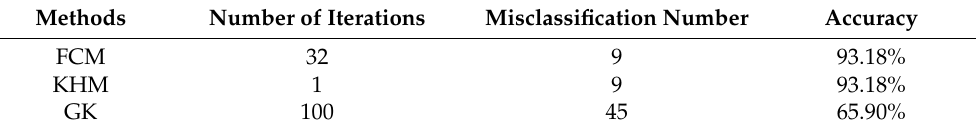
Table 2. The clustering results of FCM, KHM, and GK with the MSC preprocessing method.